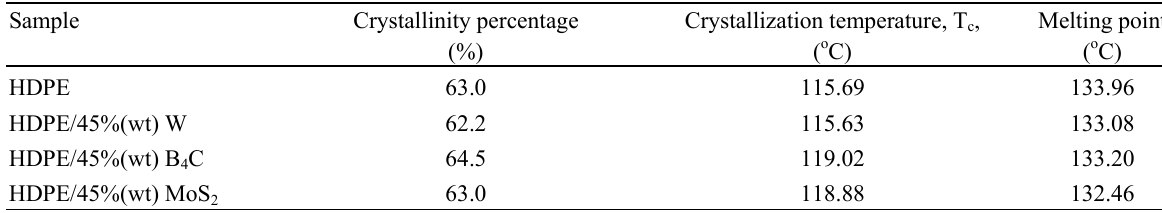
Table 6. Some Thermal Properties of